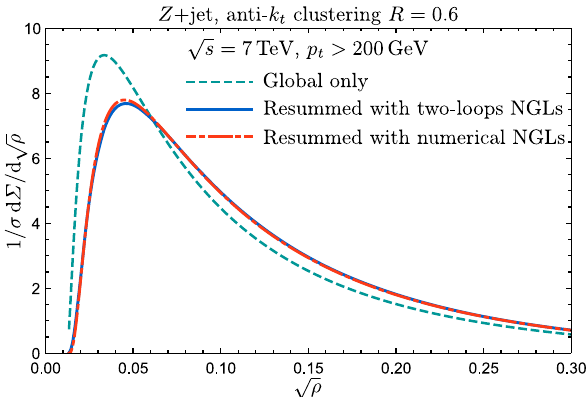
Fig. 8 The full resummed differential jet mass distribution in the anti- k t jet algorithm with NGLs factor as an exponential of the two-loops result and as an all-orders numerical result obtained from Ref. [11]. We explain the in the next section how these plots are